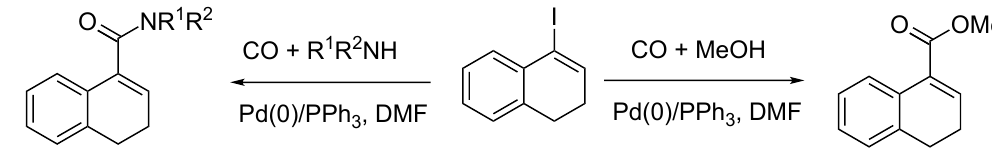
Figure 11. Pd-catalyzed aminocarbonylation of